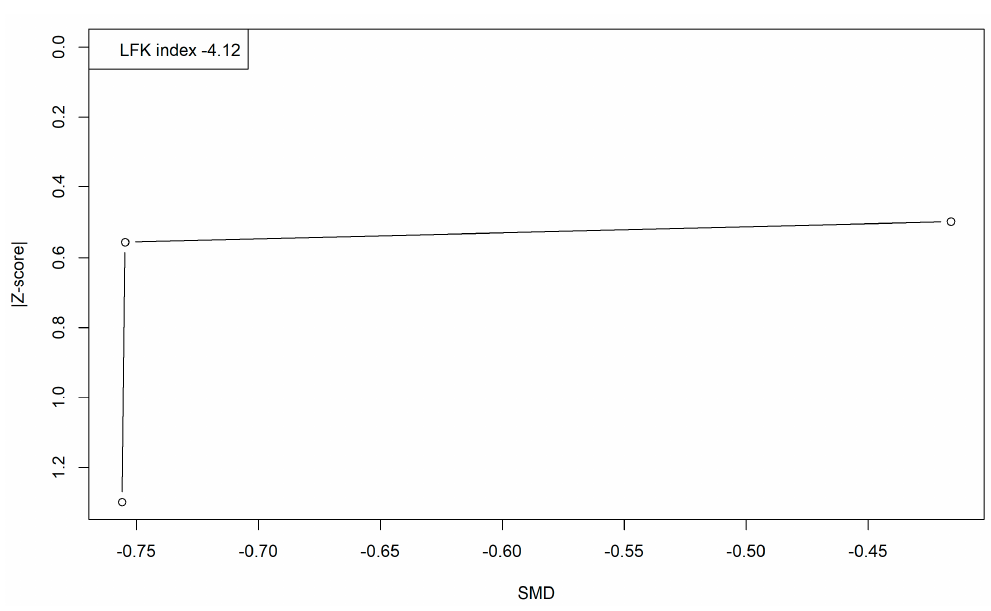
Drapery plot of all studies of the studies included in the sensitivity